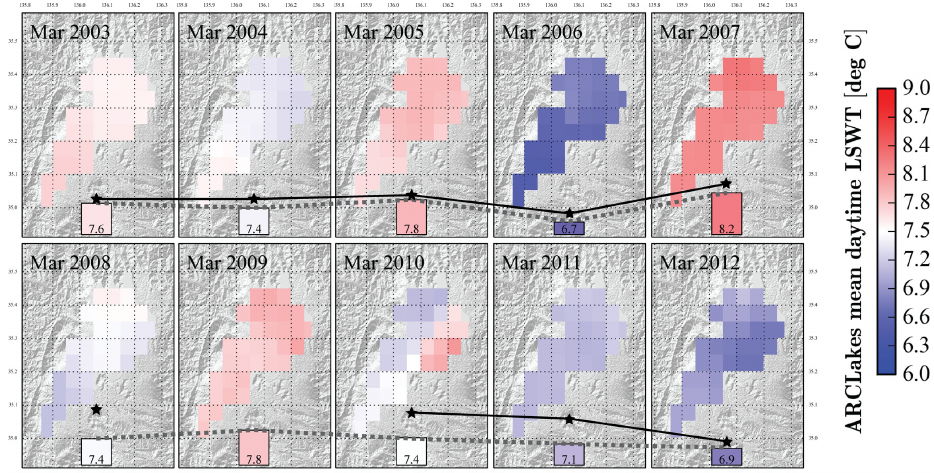
Figure 13. Lake surface water temperature (LSWT) in March in Lake Biwa ( lswt_n_mean ). The March LSWT marks the annual minimum for every year contained in the dataset.